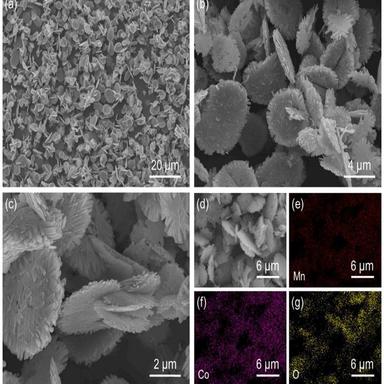
(a–d) SEM images of MnCo2O4-discs obtained at 110 ◦C, and the corresponding elemental mapping images of (e) Mn, (f) Co and (g) O.